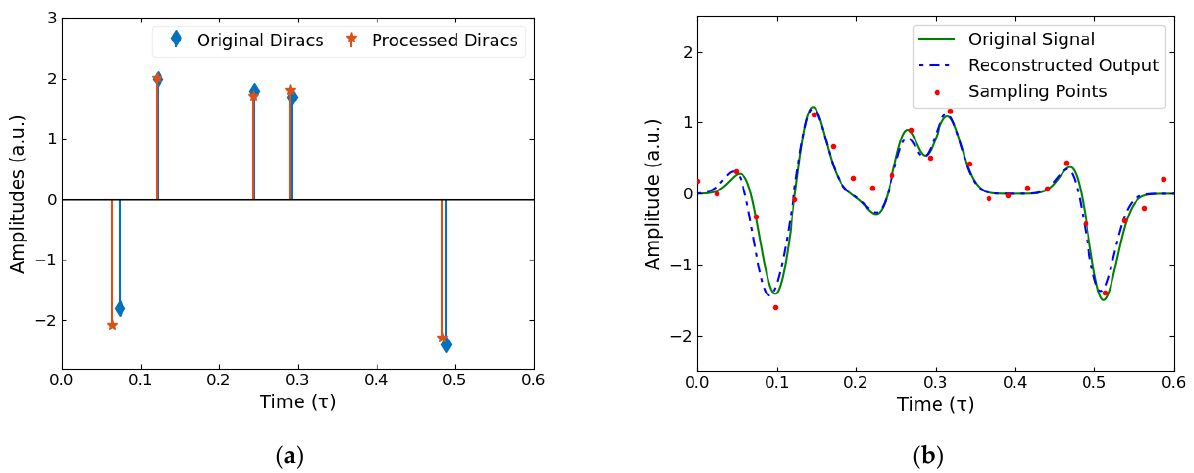
Figure 3. Simulated results with a Gaussian white noise model to give a signal to noise ratio of 6 dB. ( a ) Simulated results in the presence of noise (orange), with the original (blue) for comparison. ( b ) Reconstruction of the simulated signal with the presence of noise (dashed blue line), compared to the original noiseless signal (green line) and the sampling points (red points).